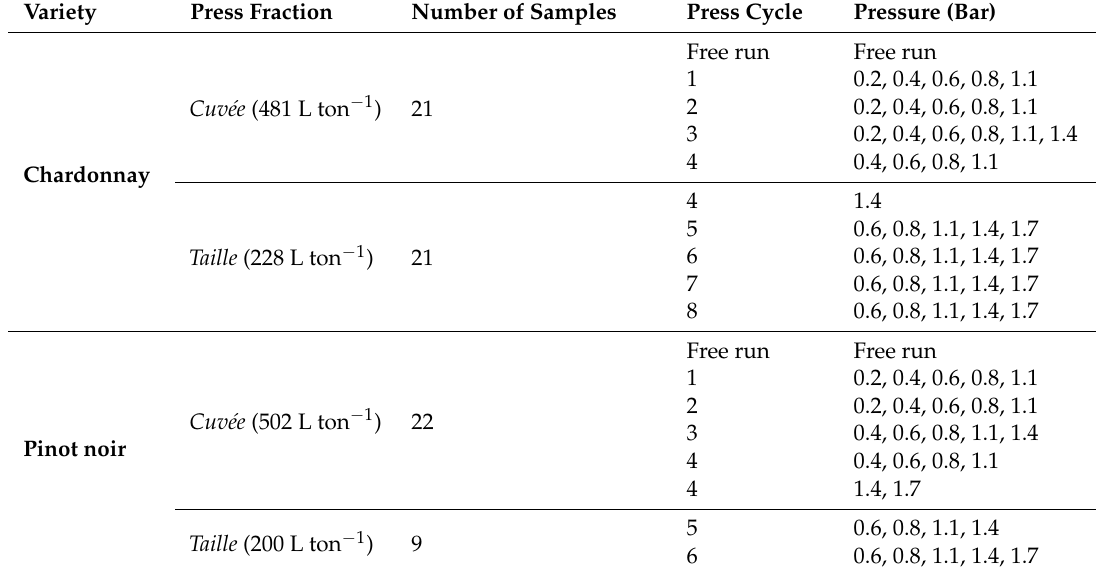
Table 1. Pressing operation parameters during the 2011/12 commercial scale trial.